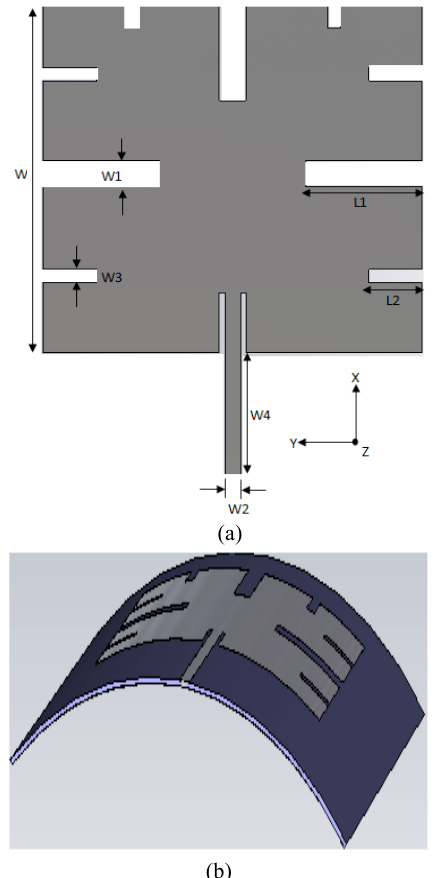
Figure 1: The top views of (a) Planar antenna (b) Conformal antenna with 60mm radius of curvature